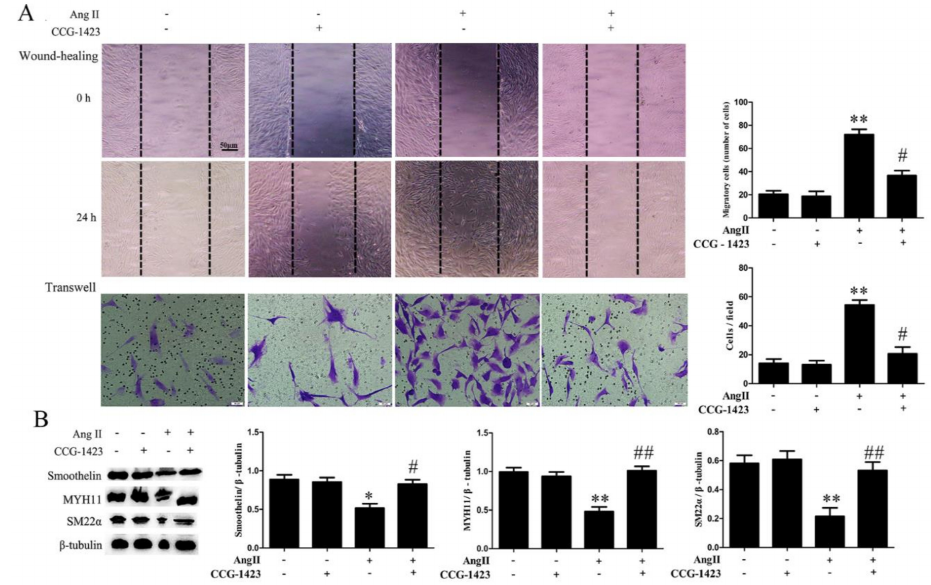
Figure 4. The e ff ects of RhoA inhibitor CCG-1423 on cell migration and the expression of contractile marker proteins in HA-VSMCs. Cells were pretreated with CCG-1423 (20 µ M) for 18 h and then exposed to 100 nM Ang II for 24 h. Untreated cells were used as the control. ( A ) Cell migration was detected by wound-healing and Transwell assays. Histograms show the quantification of the wound healing and Transwell assay results. The scar bar is 50 µ m. ** p < 0.01 vs. the control group; # p < 0.05 vs. the Ang II-treated group ( n = 3). ( B ) Western blot analysis of MYH11, SM22 α , and smoothelin. Histograms show the ratios of MYH11 or SM22 α or smoothelin to β -tubulin. * p < 0.05 and ** p < 0.01 vs. the control group; # p < 0.05 and ## p < 0.01 vs. the Ang II-treated group ( n = 3).